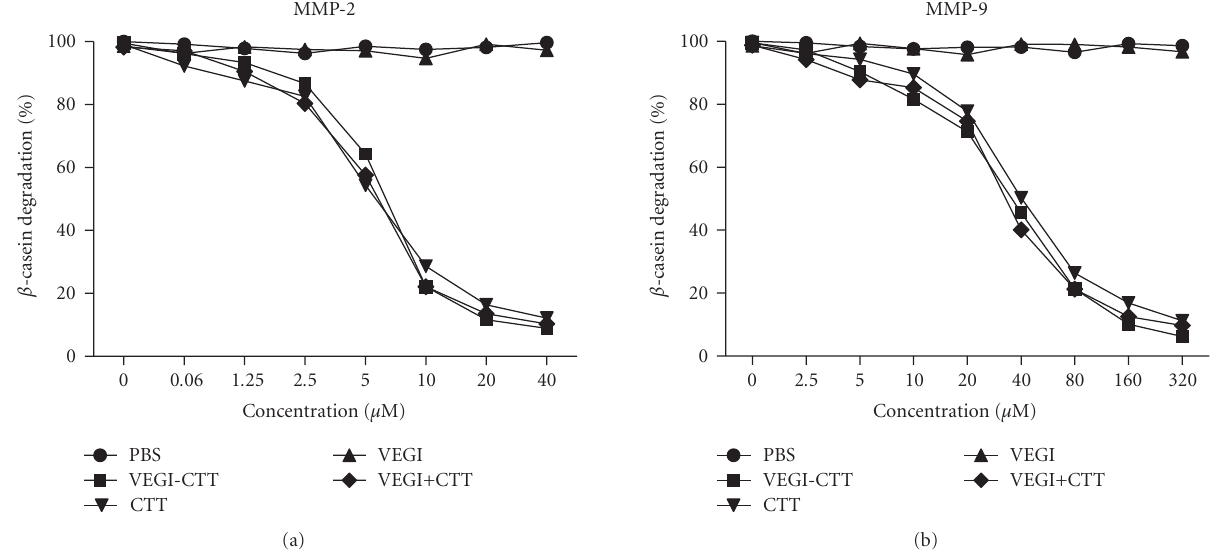
Figure 7: Inhibition of caseinolytic activity by the chimeric protein VEGI-CTT. MMP-2 and MMP-9 enzymes were incubated with 2mg/mL β -casein in the absence or presence of VEGI-CTT. Proteins were separated on a 10% SDS-polyacrylamide gel, and detected with Serve blue R. For details, see Section 2. Inhibition of MMP-2 and MMP-9 mediated β -casein degradation by VEGI-CTT at di ff erent concentrations with apparent IC50 of 7.5 μ M and 30 μ M, respectively.